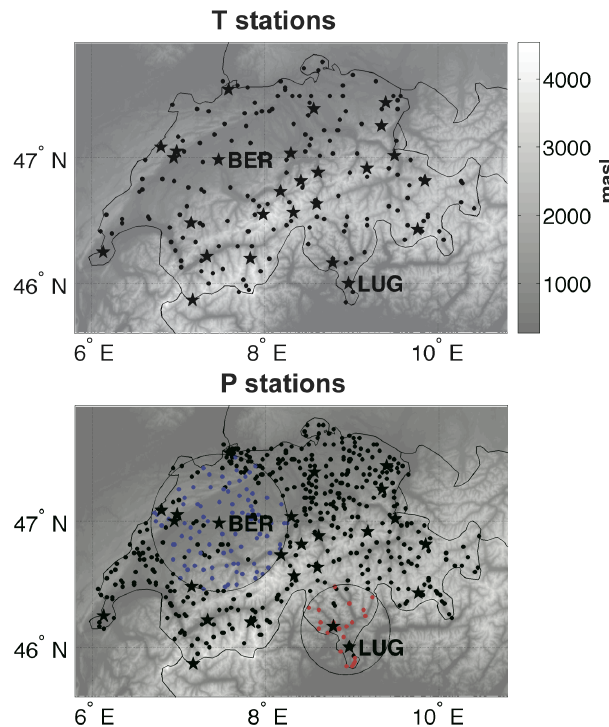
Fig. 1. Map with station locations for T (top) and P (bottom). Stars indicate stations belonging to the long-term Swiss climate monitor- ing network. Blue and red dots show the selected stations for the CHN REGION (93 stations) and CHS REGION (23 stations) experiments, respectively (see section 4).